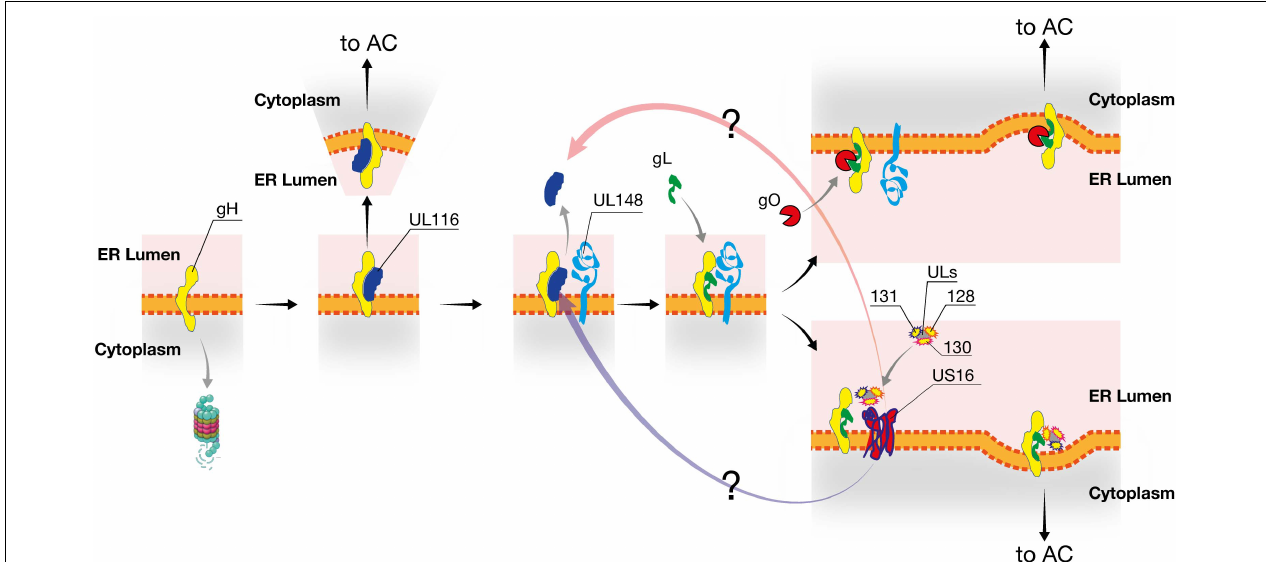
FIGURE 8 | Model of HCMV interaction in the early phases of gH complexes assembly. UL116 is the first interactor of gH in the ER and chaperones the early folding steps. UL148 is recruited through either gH or UL116 and favors the binding of gL and successive association of gO. At limiting availability of UL148, for example engaged by Sel1A, UL116 remains bound to gH and traffic through the secretory pathway reaching the assembly complex and then the mature virion. UL116 can also be released from gH in the absence of UL148, either at low efficiency or by the intervention of US16 or an unknown factor, allowing gL binding and favoring further incorporation of UL128-131 versus gO. Interaction of US16 with UL116 or other HCMV proteins is merely speculative.